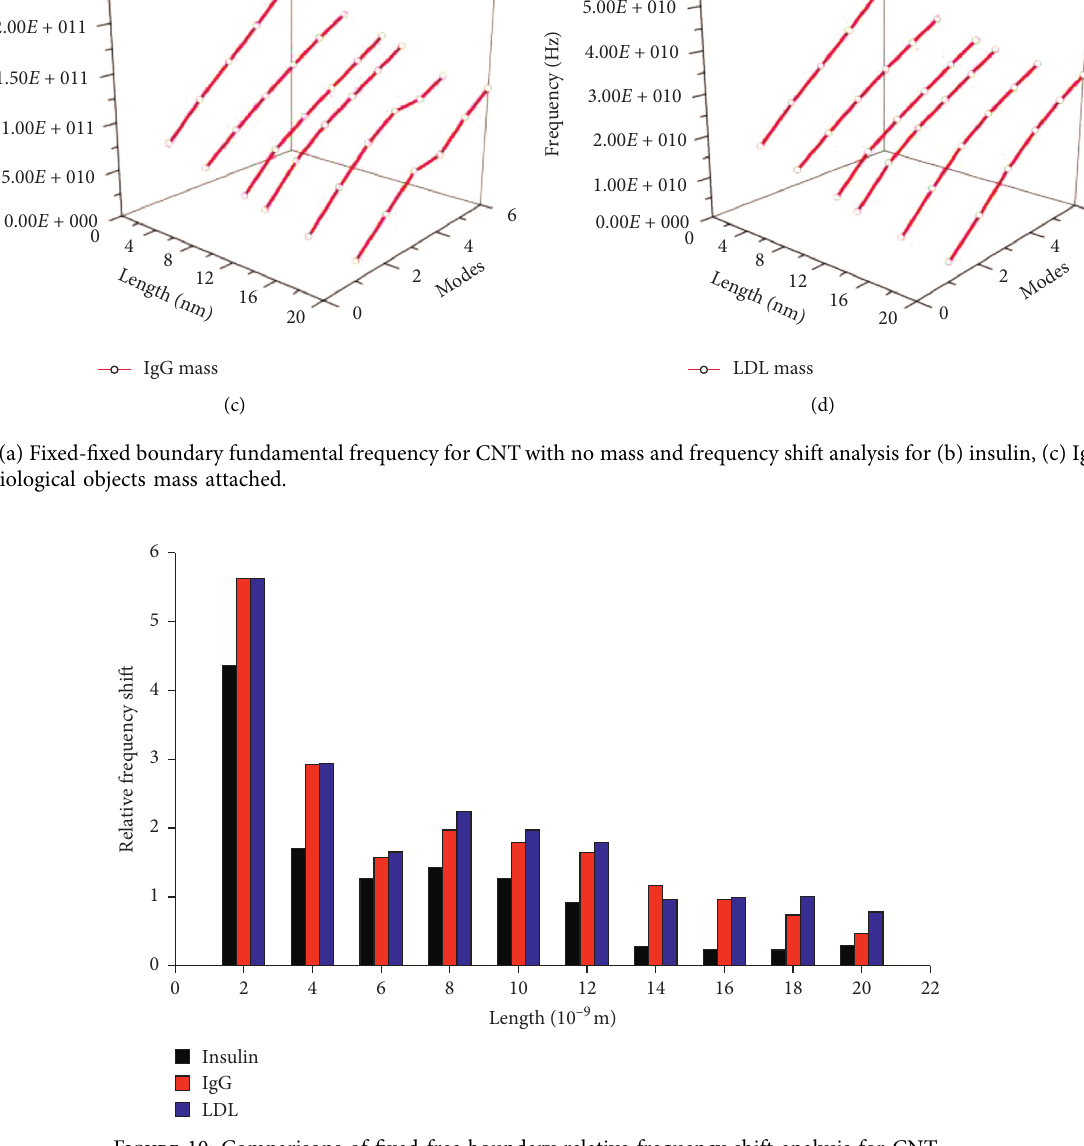
Figure 10: Comparisons of fixed-free boundary relative frequency shift analysis for